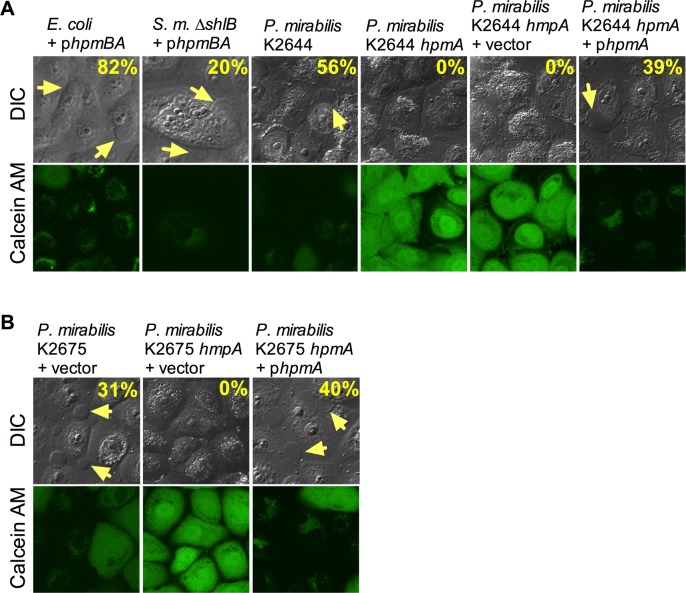
A shlBA-like Type Vb secretion system operon from P. mirabilis induces blebbing and cytotoxicity.Confocal micrographs of HCLE cells imaged with differential interference contrast (DIC) and calcein AM viability stain. Yellow arrows indicate blebs extending from corneal cells. (A) Confocal micrographs of HCLE cells with E. coli strain (Top10), S. marcescens (S. m.) ΔshlB, and P. mirabilis keratitis isolate K2644 and isogenic hmpA mutant strain (MOI = 50, 2 h incubation, 1 hour with E. coli). (B) As in (A), using P. mirabilis keratitis isolate K2675. phpmBA = pMQ601; vector = pMQ132; phpmA = pMQ602.